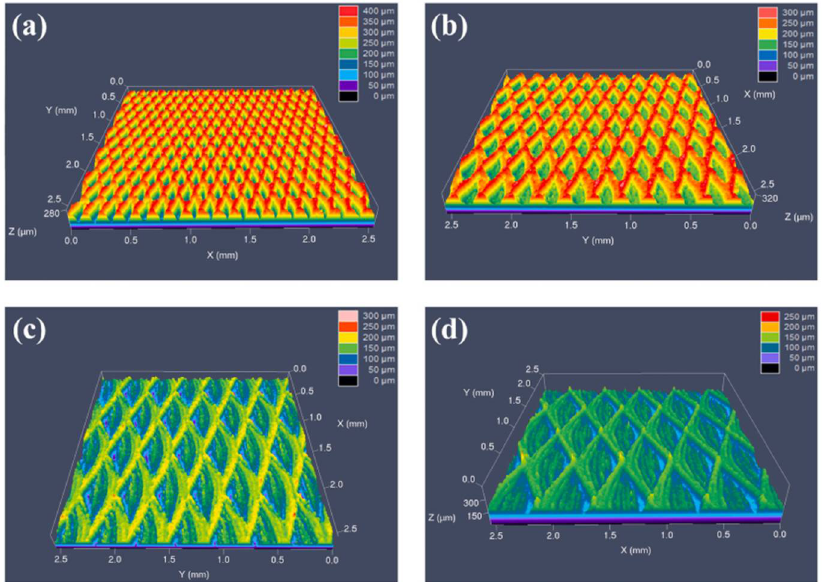
Figure 7. Micro-morphology of the bionic fish-scale surface under laser confocal scanning micro- scope. ( a ) Micro-morphology image of 30%-size fish-scale surface. ( b ) Micro-morphology image of 50%-size fish-scale surface. ( c ) Micro-morphology image of 80%-size fish-scale surface. ( d ) Micro- morphology image of 100%-size fish-scale surface. Reprinted with permission from Ref [55]. Copy- right 2021 Elsevier.